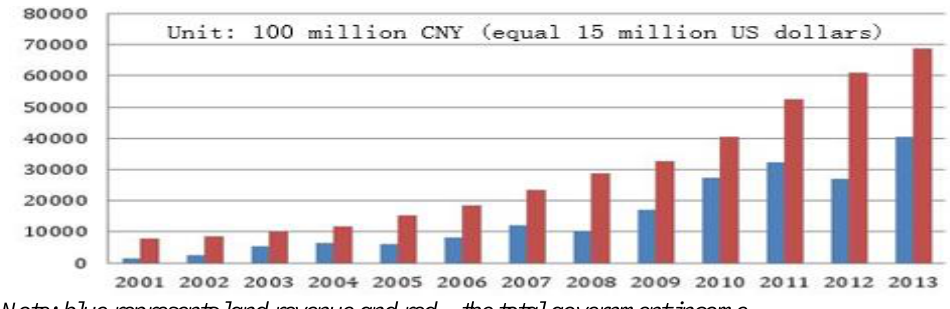
Fig. 8. The salient position of land use right transfer in the government’s income (Xu Y.,